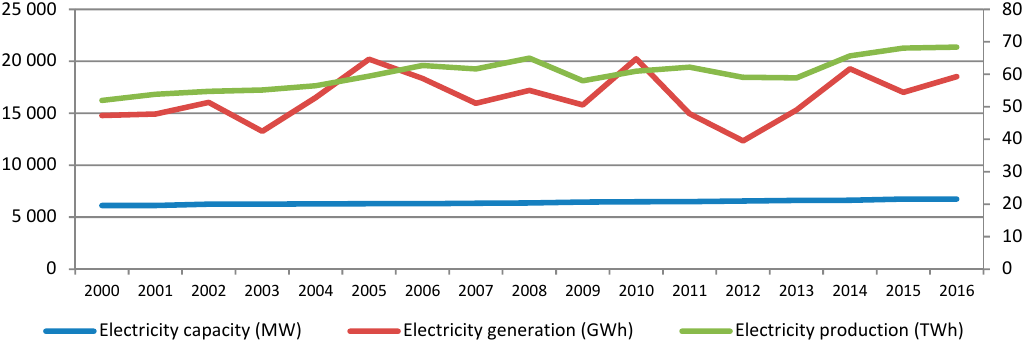
Figure 15. Main hydropower indicators evolution between 2000 and 2016, Source: Own research after Eurostat data [12].